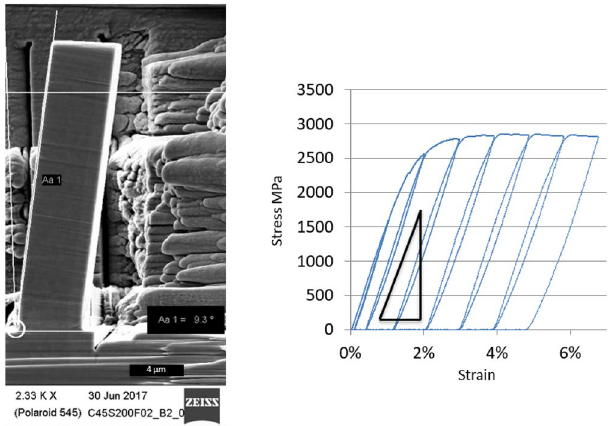
Figure 7. Beam bending experiments for elastic modulus calculation. Left: an SEM image of the bent beam after experiment; right: typical measured strain–stress curve for bending